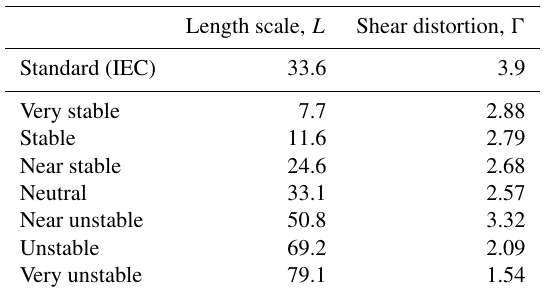
Table 3. Standard and stability-dependent turbulence parameters. Length scale, L Shear distortion,